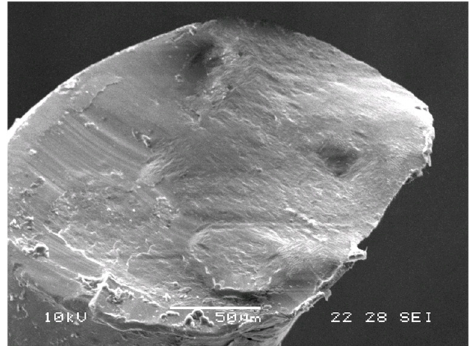
Figure 5. SEM images of the cross-section of high-strength micro steel fibre.